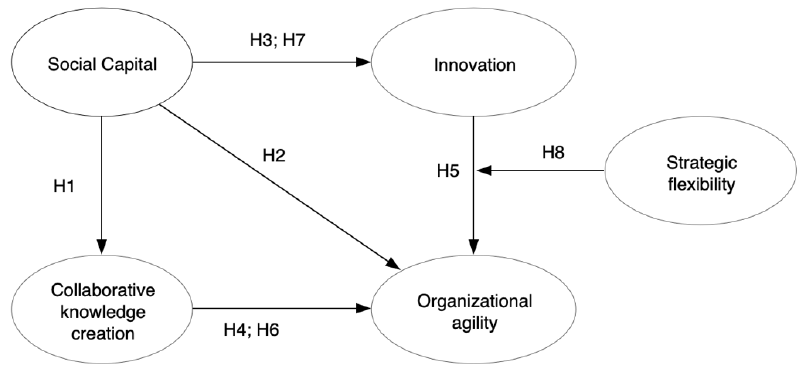
Figure 1. Conceptual